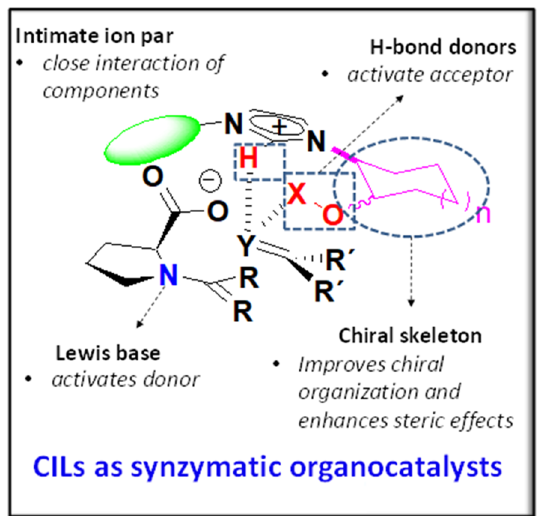
Figure 1. Main structural elements considered in the design of chiral imidazolium prolinates for their implementation as organocatalysts for aldol processes.